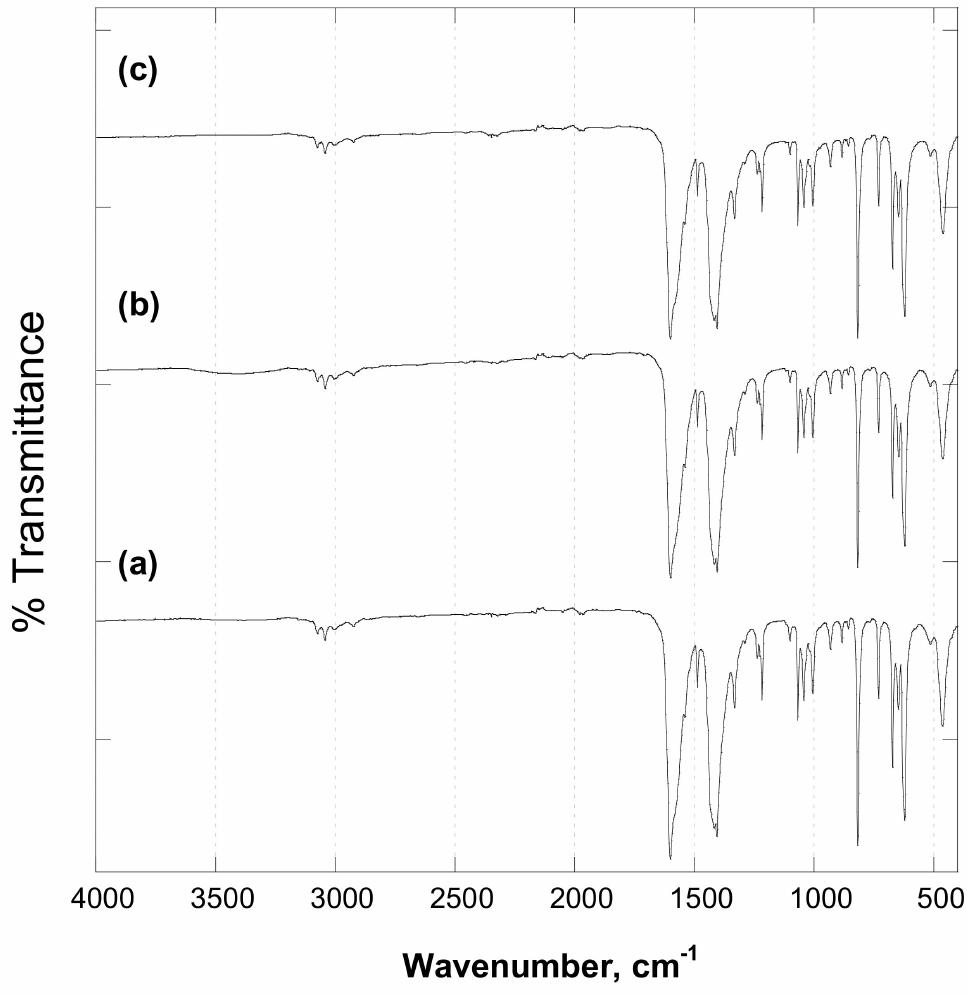
Figure 6. Infrared spectra of [Zn(4,4 (cid:48) -bipy) 2 (OAc) 2 ] ∞ samples prepared by the sonochemical process: ( a ) sample A; ( b ) sample B; ( c ) sample